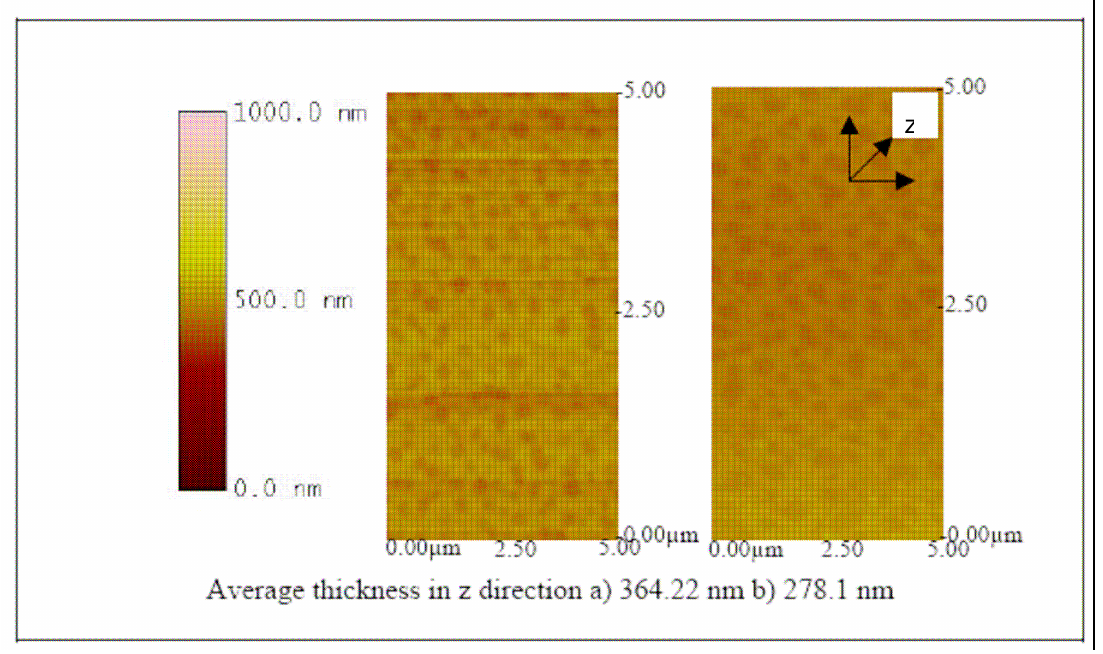
Figure 13. Atomic force microscopy images of a) ITO-Pani biosensor (50KDa) tested with a)